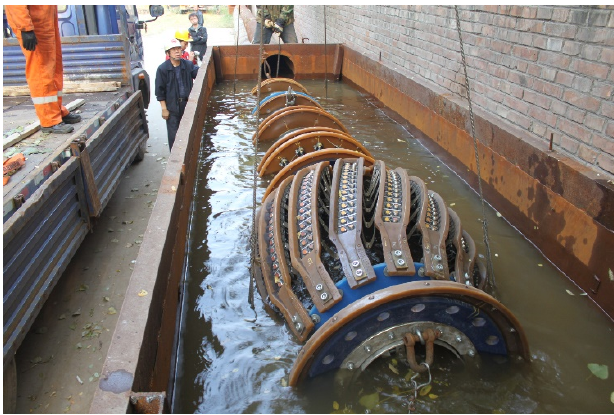
Figure 5. Pull test pipe facility and tool.